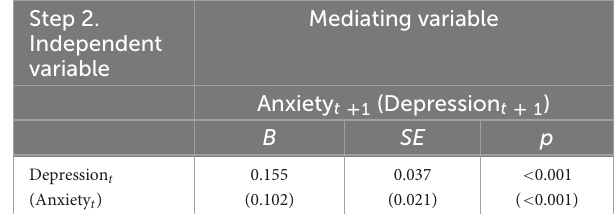
TABLE 7 Step 2 in mediating analysis of Depression t , Anxiety t + 1 , and Depression t + 2 are outside the parentheses; mediating analysis of Anxiety t , Depression t + 1 and Anxiety t + 2 are inside the parentheses. Step 2.